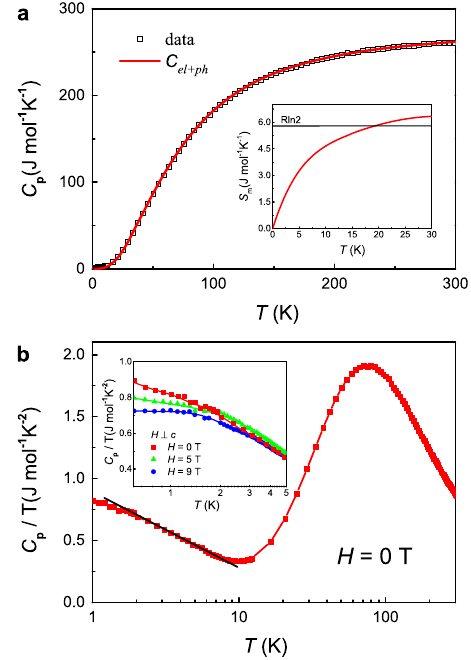
Fig. 4 Temperature dependence of the speci fi c heat. a The zero- fi eld speci fi c heat C p as a function of temperature on a linear scale. The solid line represents the theoretical fi t between 30 and 300 K using a Debye – Einstein model for the phonon contribution. The inset shows the magnetic entropy calculated from the speci fi c heat data after subtracting the phonon contribution. b Temperature dependence of C p / T on a semilogarithmic scale, showing a logarithmic divergence between 2 and 10 K. The inset plots the = 0, 5, 9 T in fi eld variation of C p / T at low temperatures for H perpendicular to the c